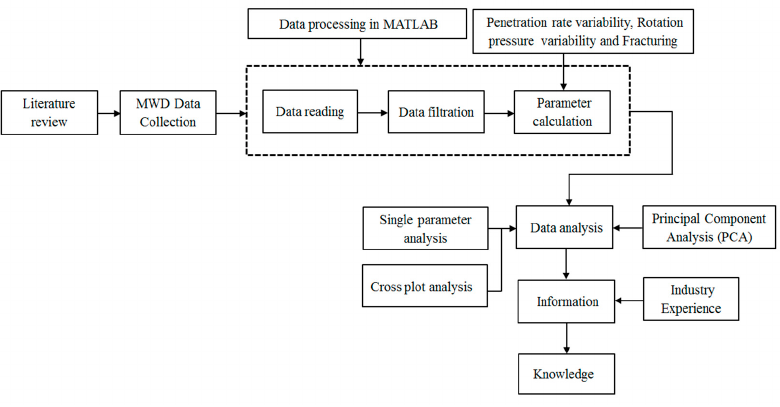
Figure 1. Research Figure 1. Research methodologies.